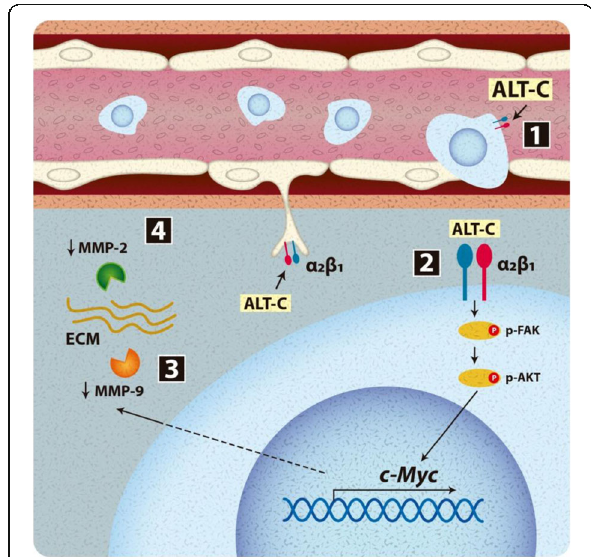
Fig. 7 Potential mechanism of ALT-C in the tumor microenvironment and cancer progression. ( 1 ) Transmigration of breast tumor cells (in blue) through endothelial cells is induced by low concentrations of ALT-C. ( 2 ) ALT-C binds to α 2 β 1 integrin, triggering c-Myc upregulation via p-FAK and p-AKT activation resulting in downregulation of the proteins ( 3 ) MMP-9 and ( 4 ) MMP-2, thus decreasing tumor cell invasion into ECM. ALT-C also acts via α 2 β 1 integrin on endothelial cells, decreasing MMP-2, which inhibits the formation of new blood